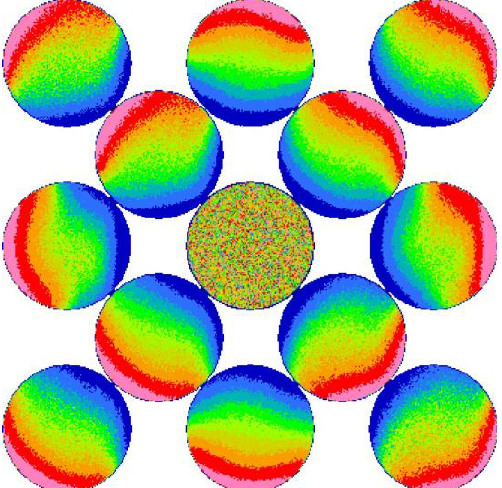
Figure 6. Computational result of the measurement of the eye in Figure 5b and c. No accommodation was applied. Intraocular scattering was applied to produce the outer eccentric